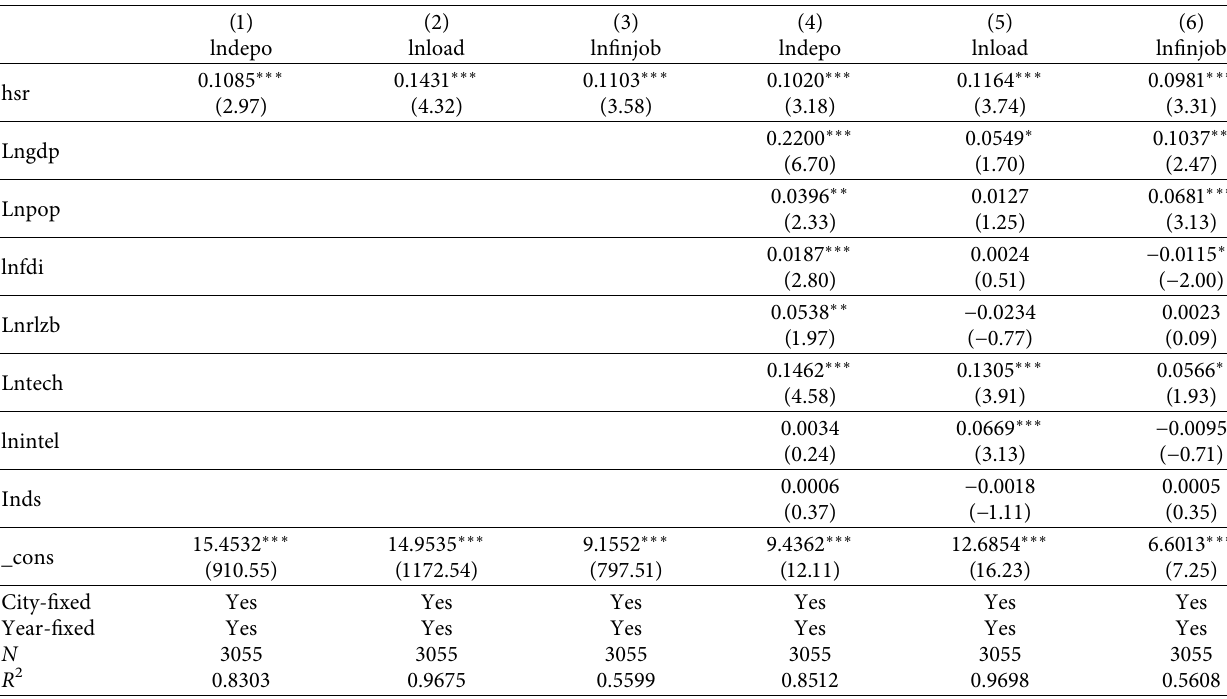
Figure 2: Parallel trend check chart. Table 2: Estimated results of the baseline